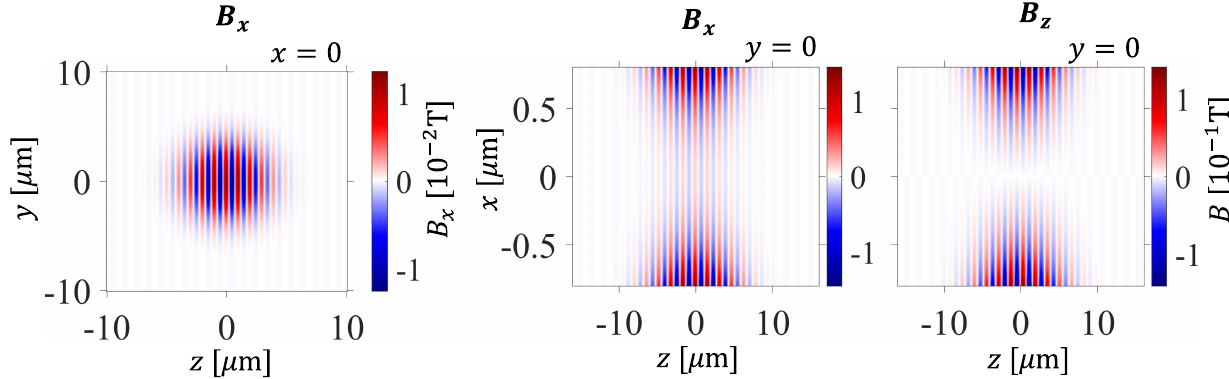
Fig. 5 Magnetic fi eld of nano-undulator. To visualize the undulator used in our calculations, we plot the corresponding magnetic fi elds in the x = 0 and y = 0